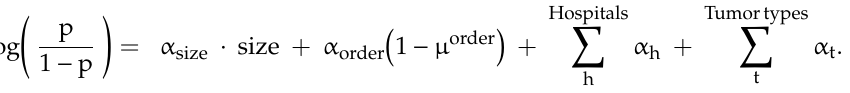
Table S1: Number of robotic surgeries per hospital during the introduction of robot assisted radical hysterectomy (RRH) ( ≤ 50 surgeries) and the experienced years ( > 50 surgeries). Rate of recurrence and tumor size in the cohort without Radio chemotherapy (RC-T) presented per